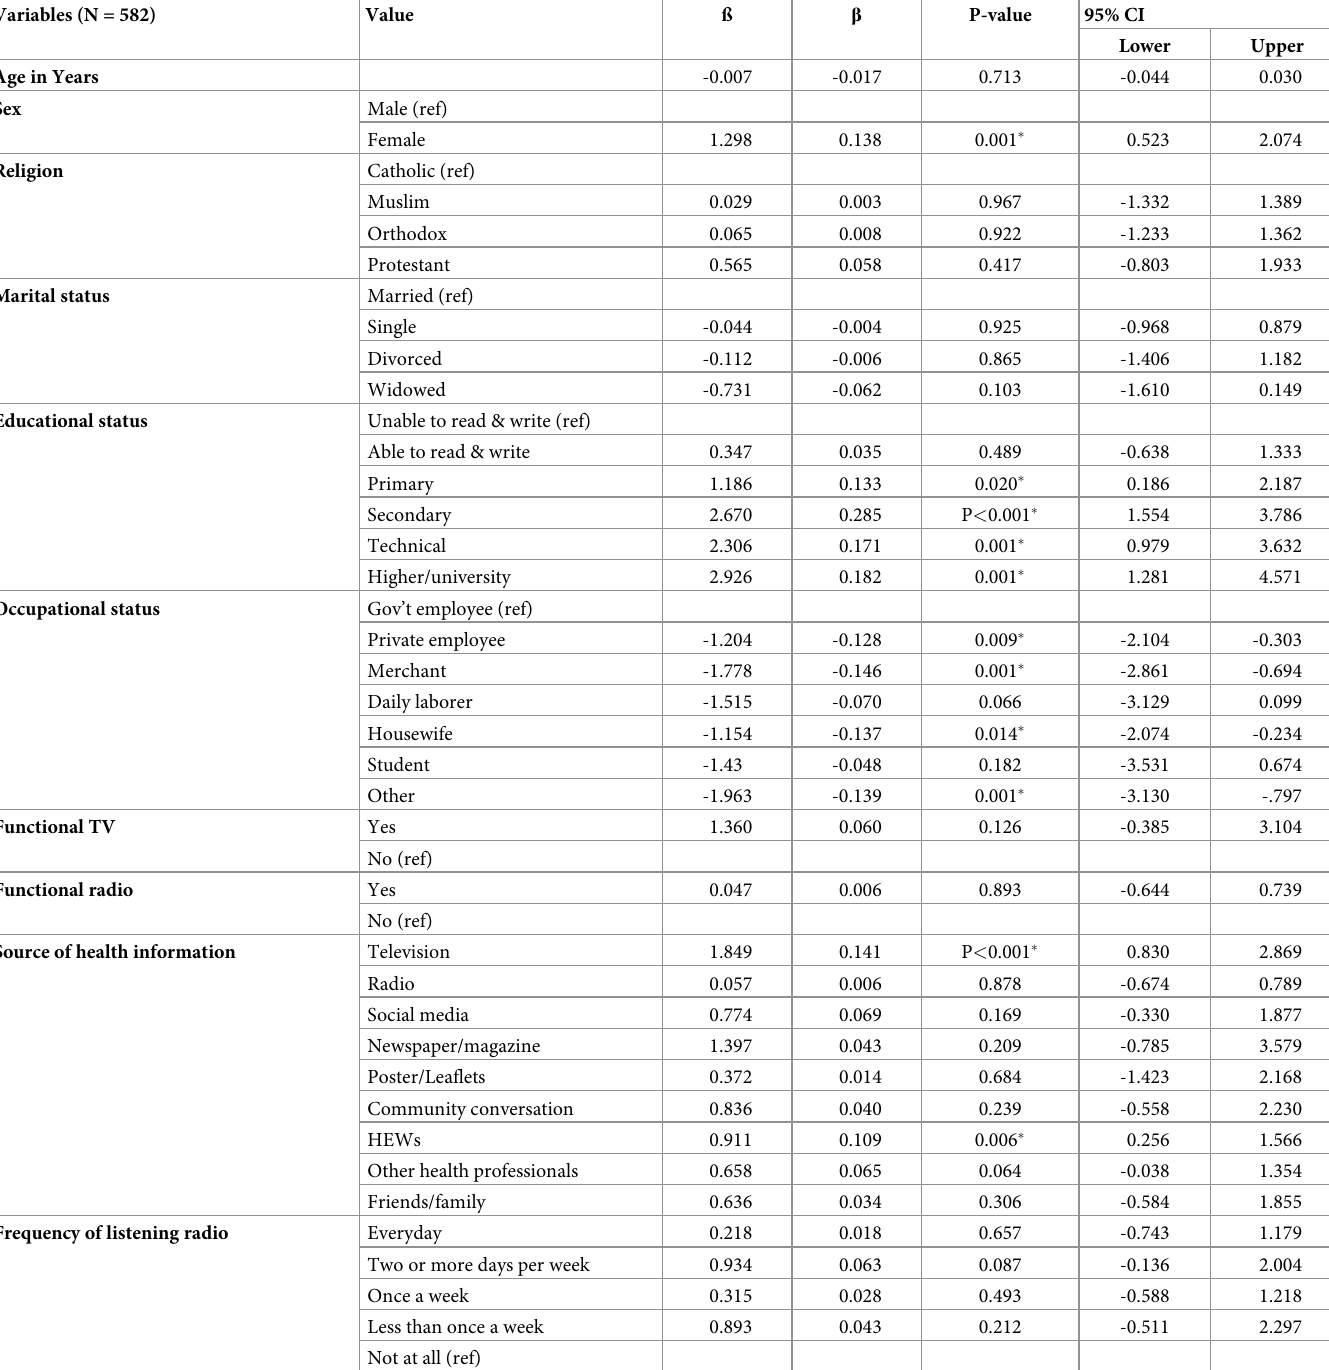
Table 5. Predictors of knowledge for cholera on multiple linear regression analysis among, respondents in Addis Ketema sub-city, Addis Ababa, Ethiopia,